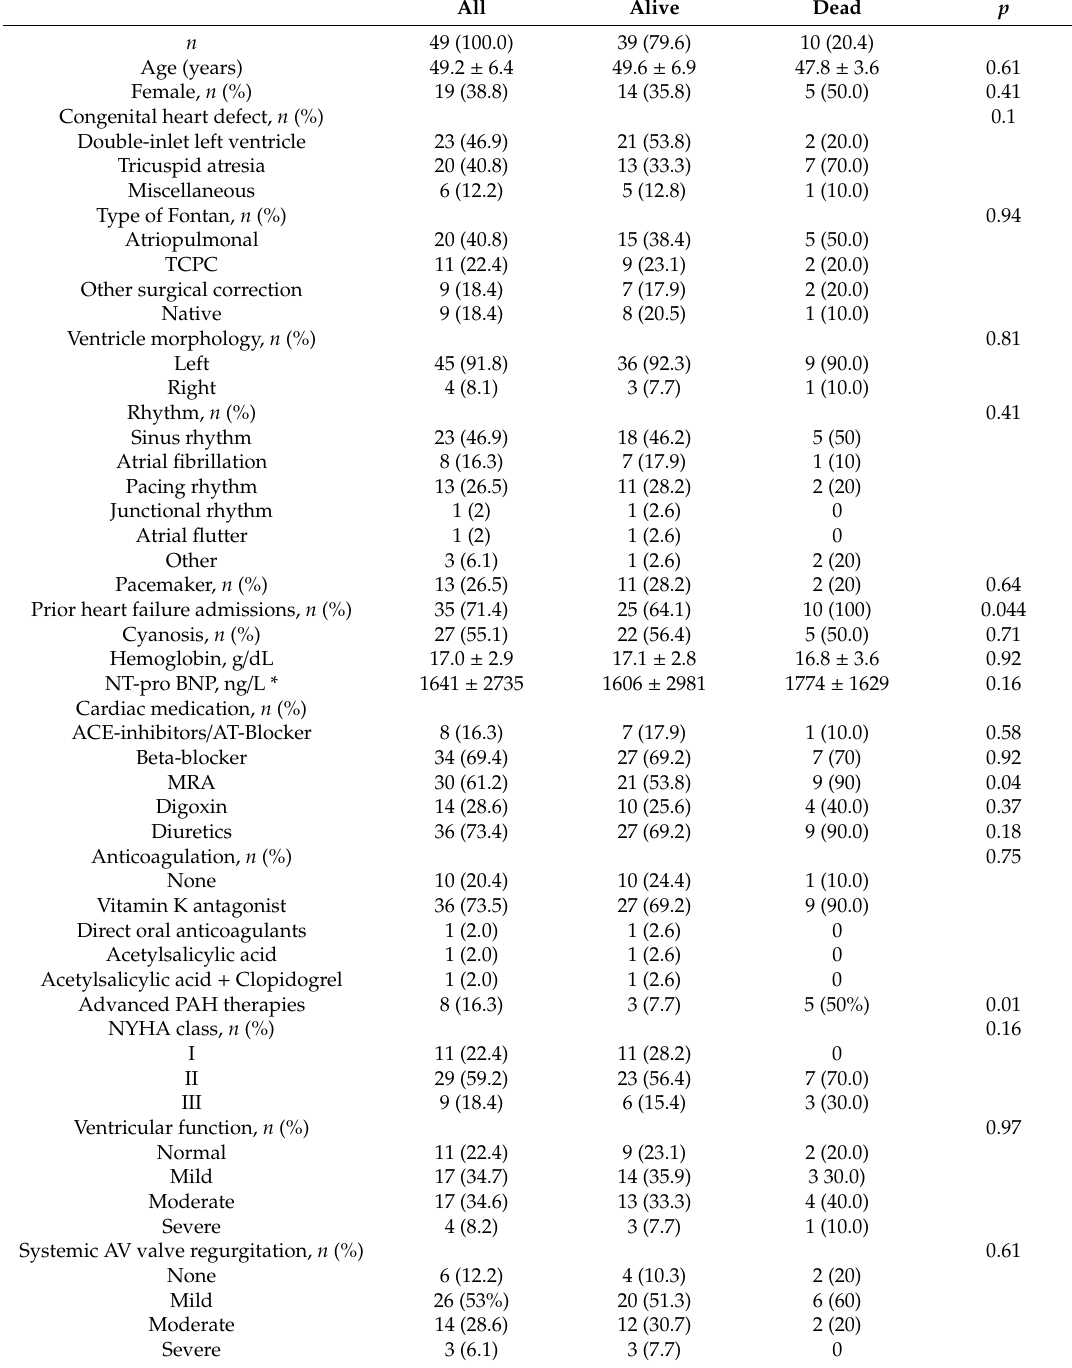
Table 1. Baseline characteristics of the study